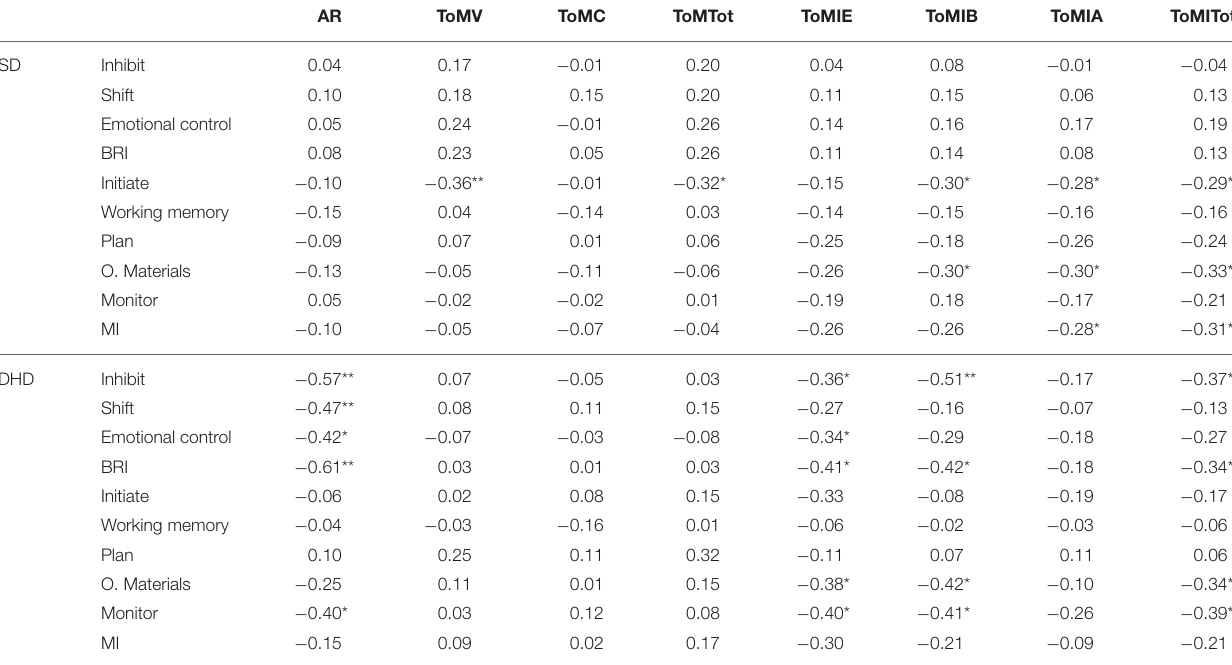
TABLE 3 | Pearson correlation coefficients between executive functions and social cognition measures in ASD and ADHD groups. AR ToMV ToMC ToMTot ToMIE ToMIB ToMIA ToMITot ASD Inhibit Emotional